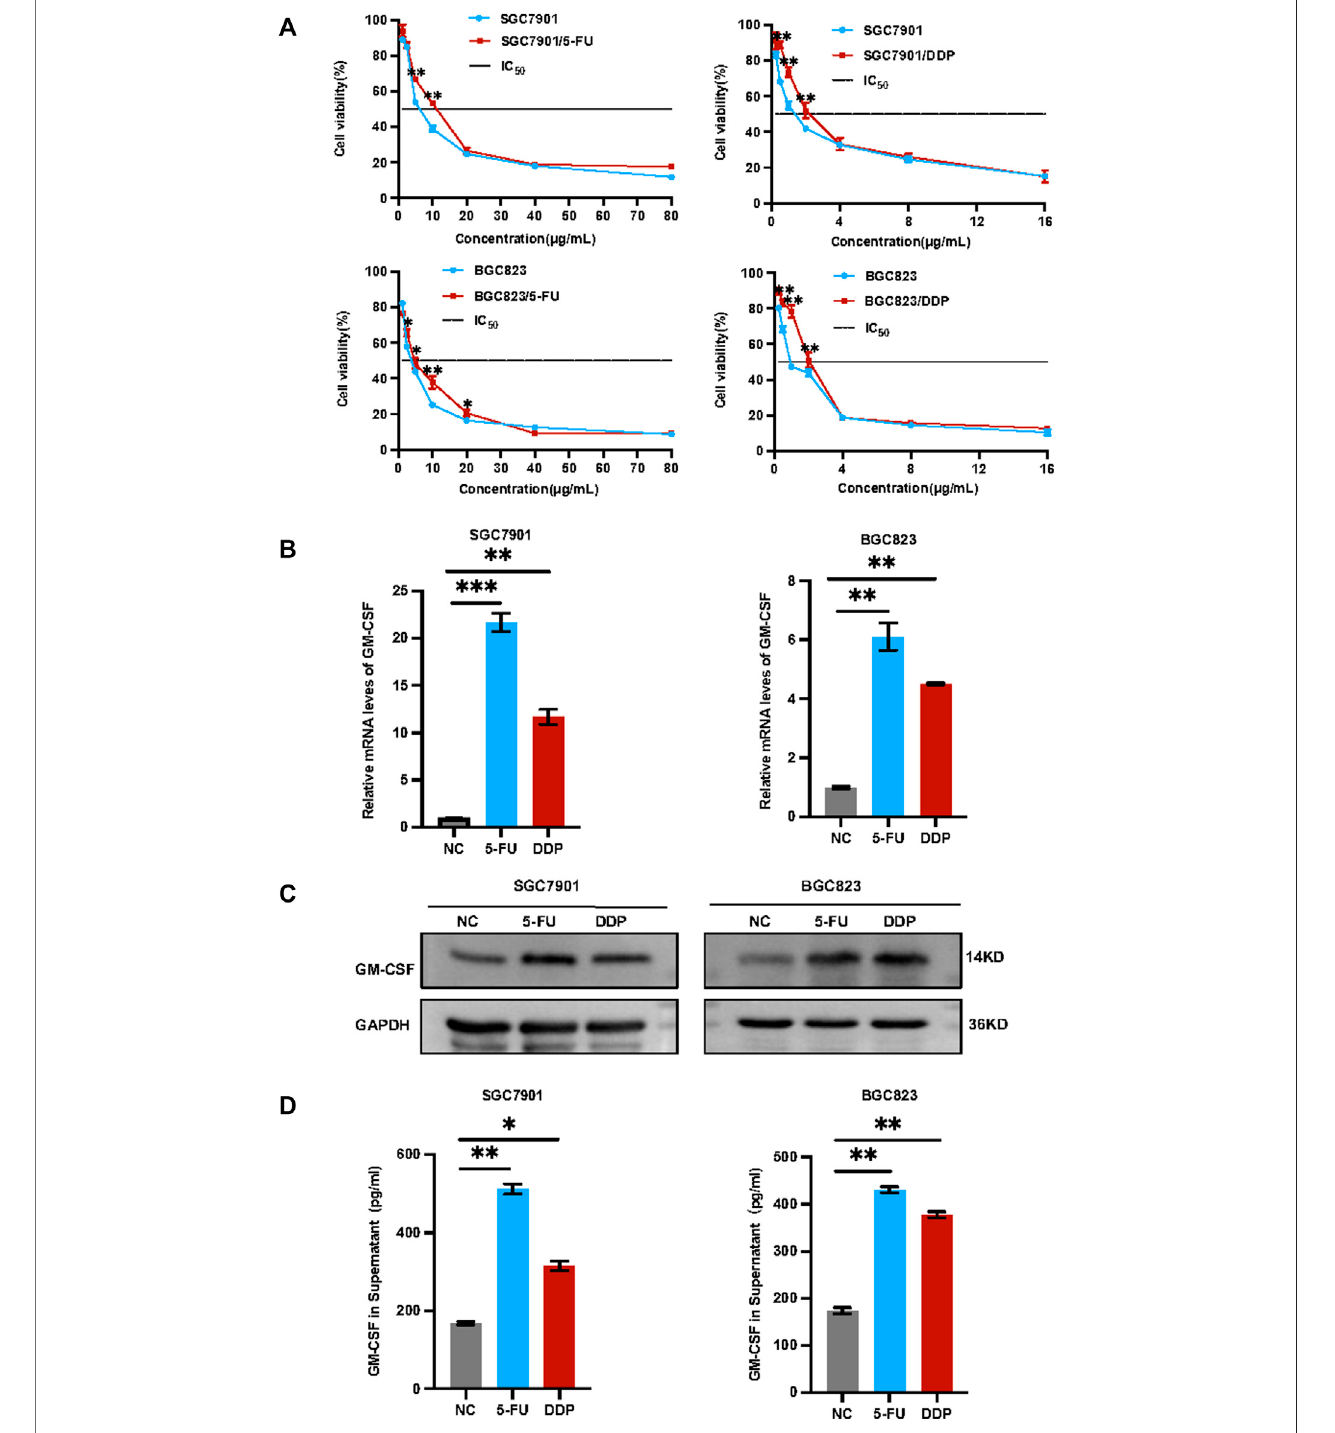
FIGURE 1 | Induction of drug resistance and GM-CSF expression/secretion in the survived gastric cancer cells after chemotherapy. (A) : IC 50 analysis of the survived SGC7901 and BGC823 cells after treatment with 5-FU or DDP for 72 h. (B) : QRT-PCR analysis of the GM-CSF mRNA levels in the survived SGC7901 and BGC823 cells. (C) : Western blot analysis of the GM-CSF protein levels in the survived SGC7901 and BGC823 cells. (D) : ELISA analysis of the GM-CSF levels in supernatants of the survived SGC7901 and BGC823 cells. Data are presented as the mean ± SEM ( N = 3). * p < 0.05, ** p < 0.01, *** p < 0.001.